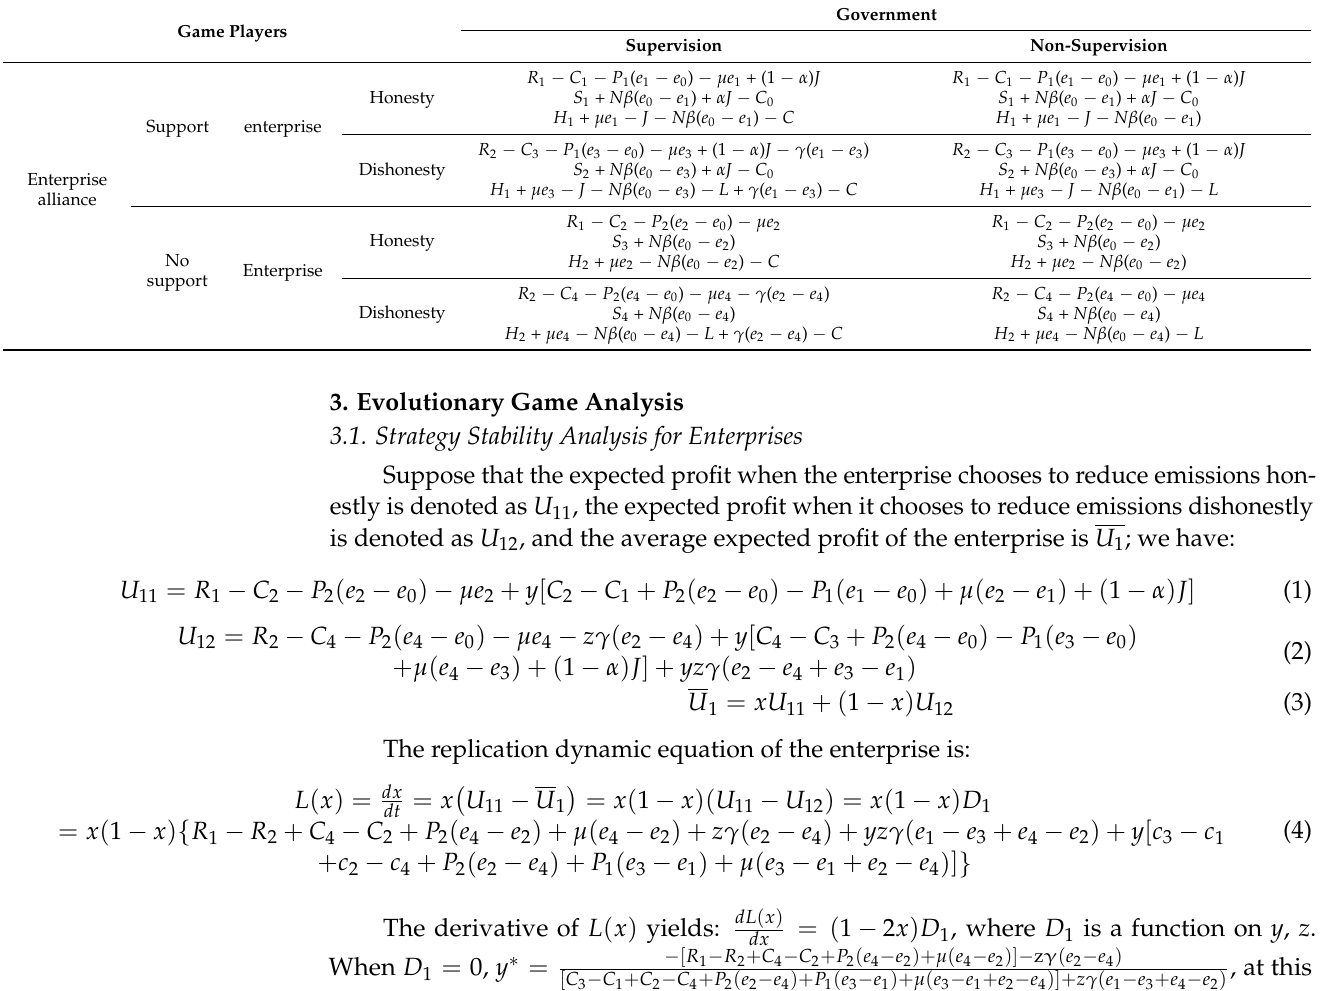
Table 2. Income matrix of government, enterprises and alliance.